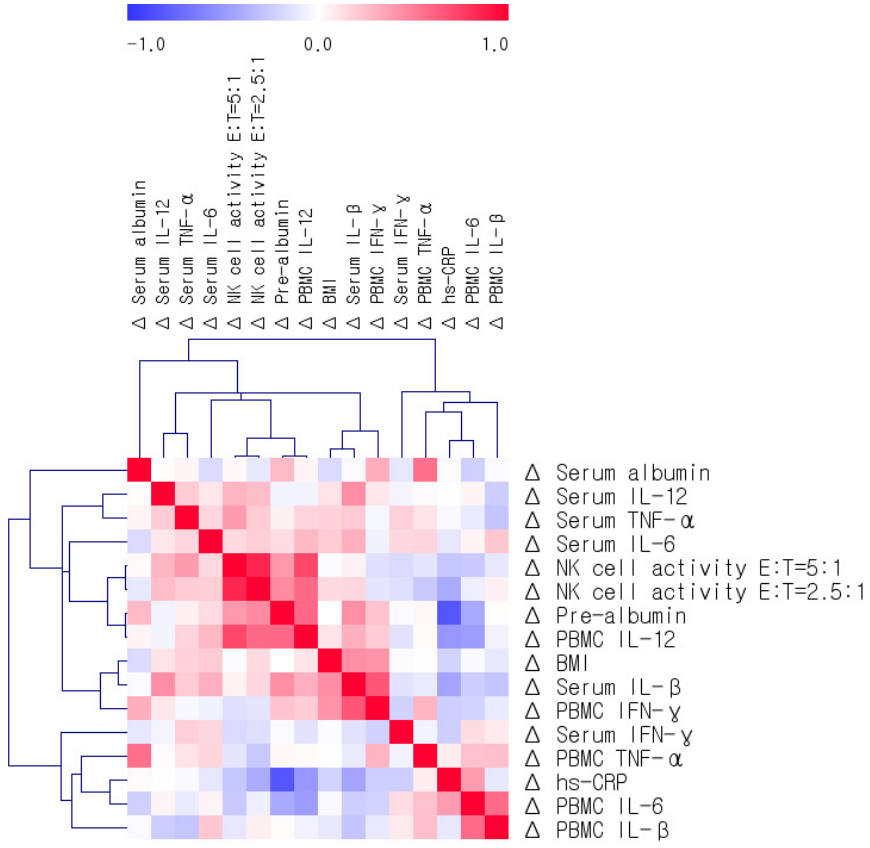
Figure 1. Matrix of correlations among changes in BMI, serum albumin, pre-albumin, cytokines, PBMC cytokine production, and NK cell activity. Correlations were obtained by deriving Spearman’s correlation coefficient. Red is a positive correlation and blue is a negative correlation.